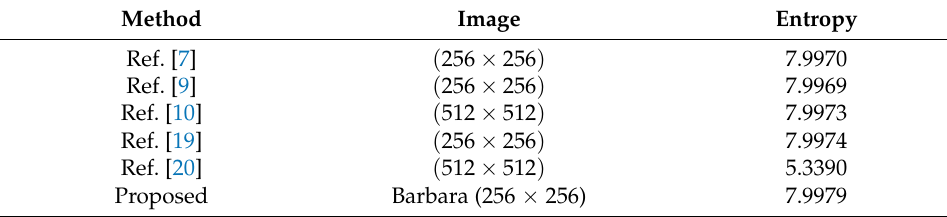
Table 8. Comparison of entropy results.